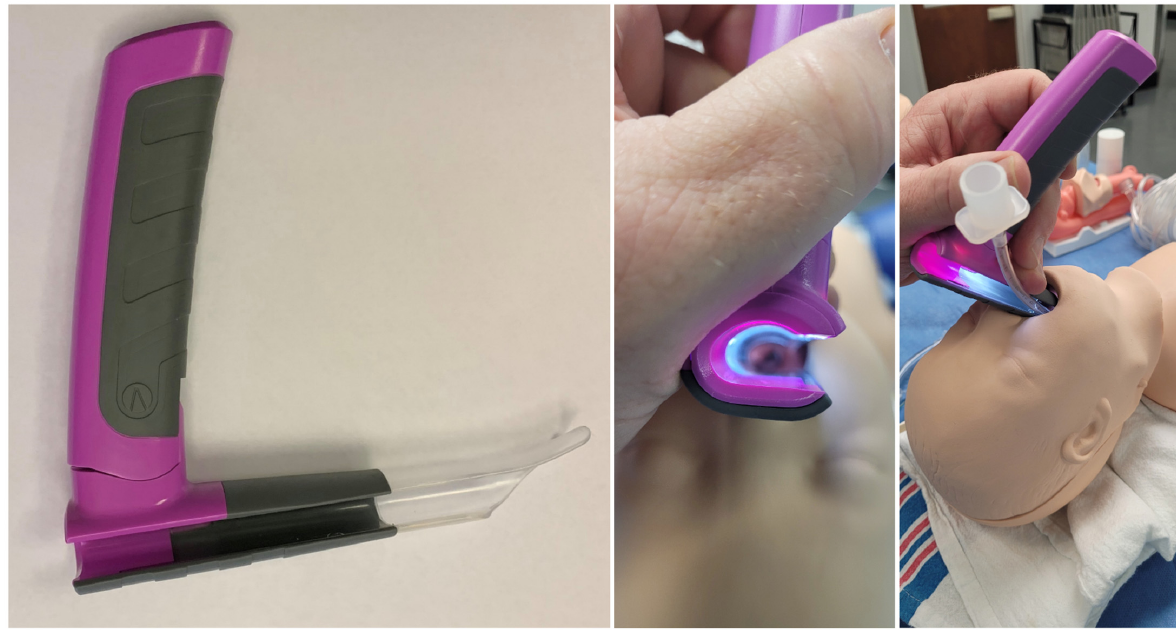
Figure 1. The bébé Vie Scope™ (Android Surgical TM , Oklahoma, OK, USA). Figure 1. The b é b é Vie Scope™ (Android Surgical TM , Oklahoma, OK,